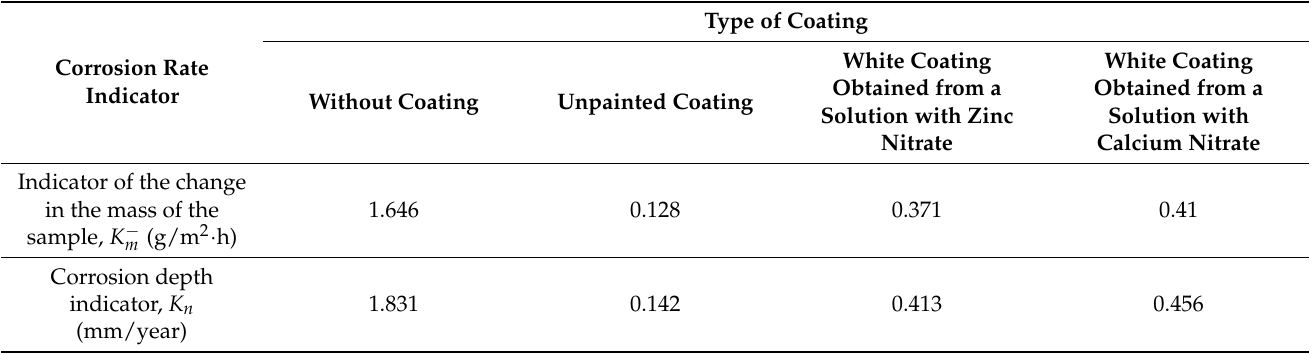
Table 2. Corrosion rates of steel samples with various modified phosphate coatings in a 3% NaCl